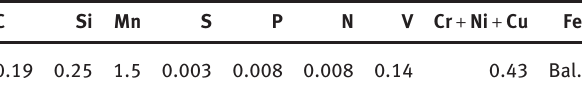
Table 1: Chemical composition of vanadium microalloyed fine grain structural steel under investigation (in mass %).